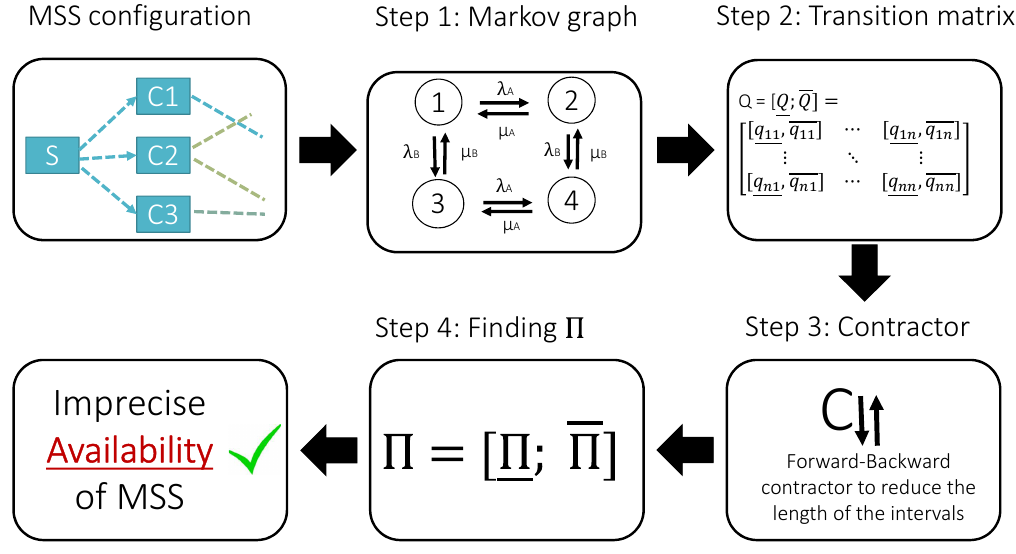
Figure 2. Steps of the proposed